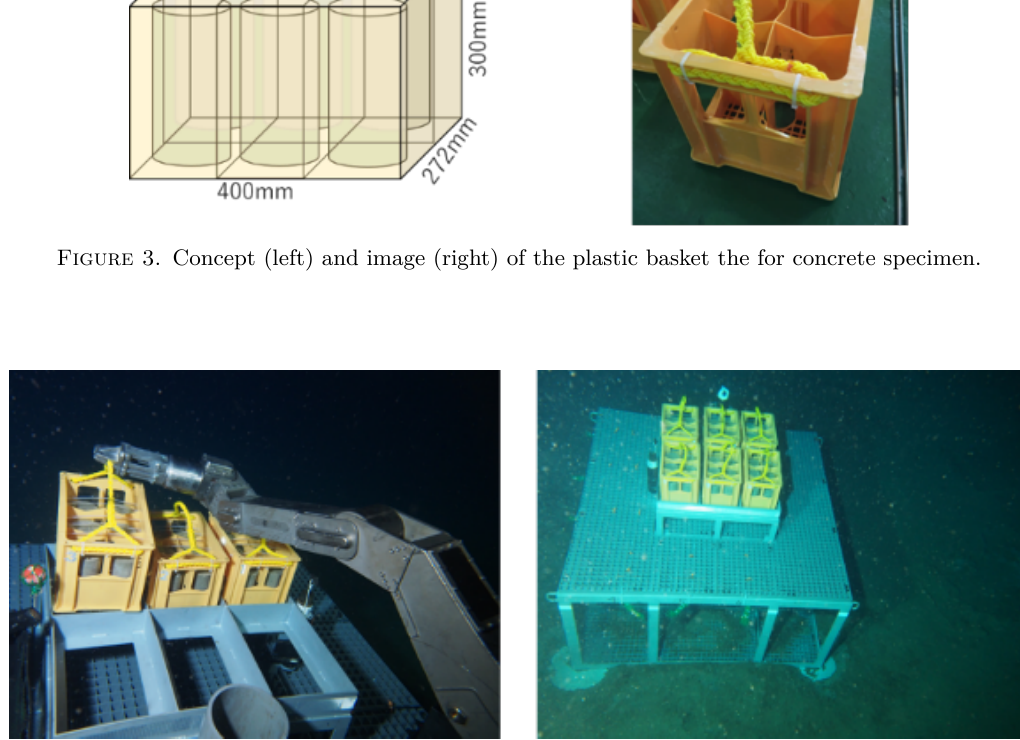
Figure 4. Installation of the basket by the manipulator (left) and top view of the exposure system (right).